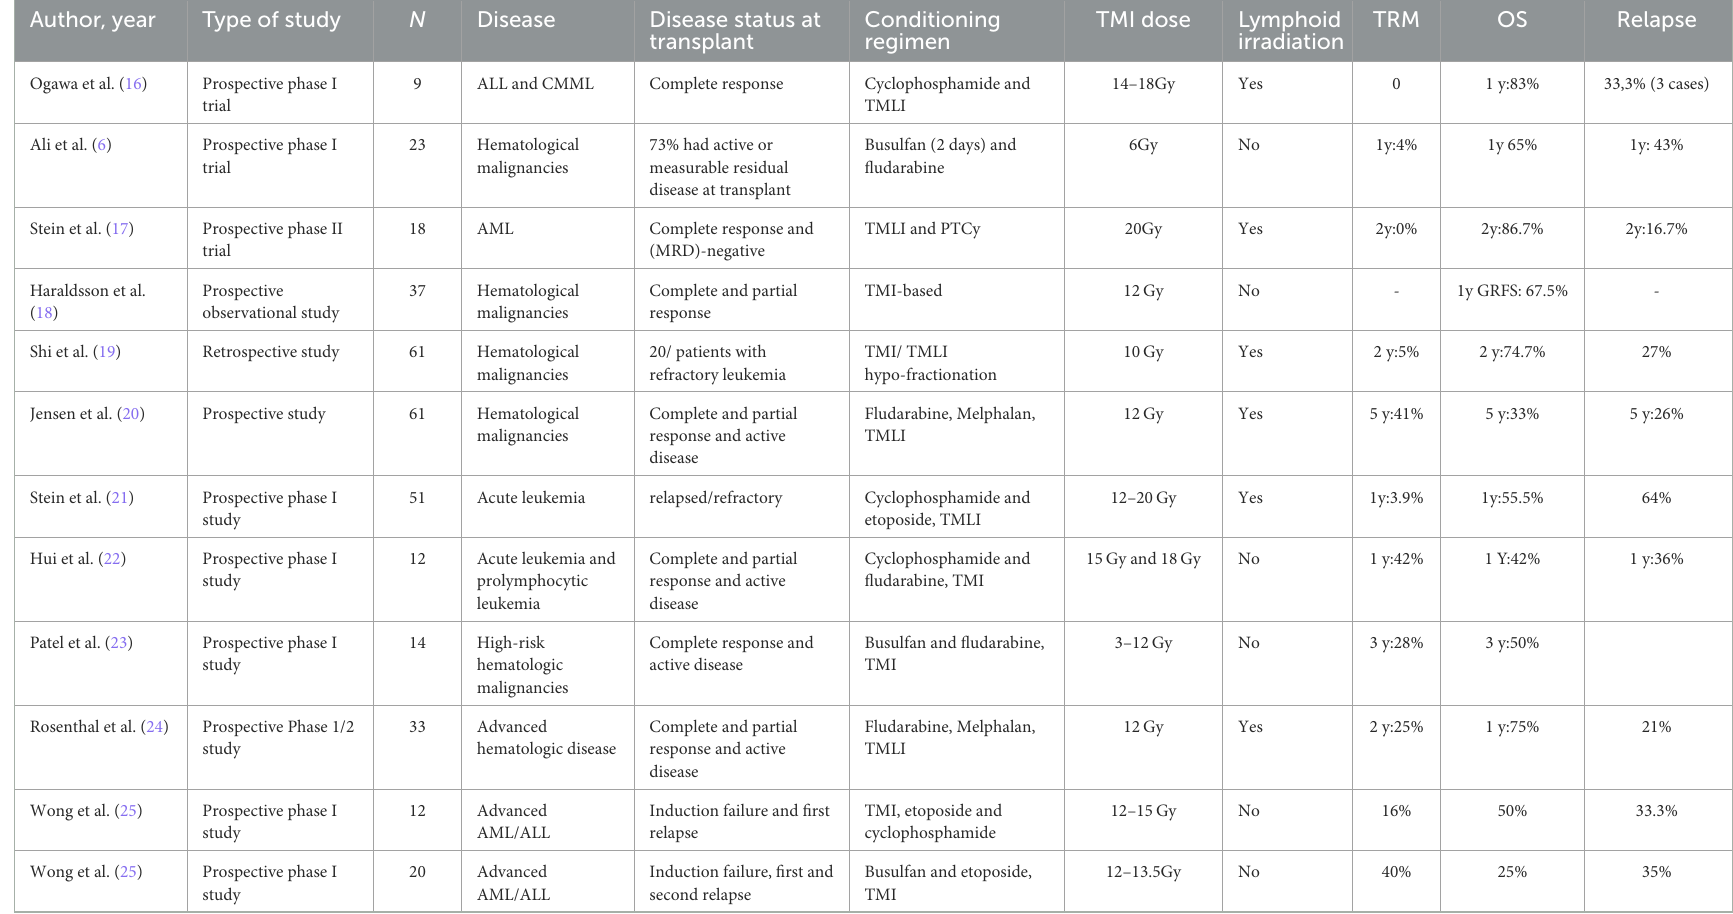
TABLE 2 Clinical results of TMI/TMLI in matched-donor allogeneic transplants. Author,